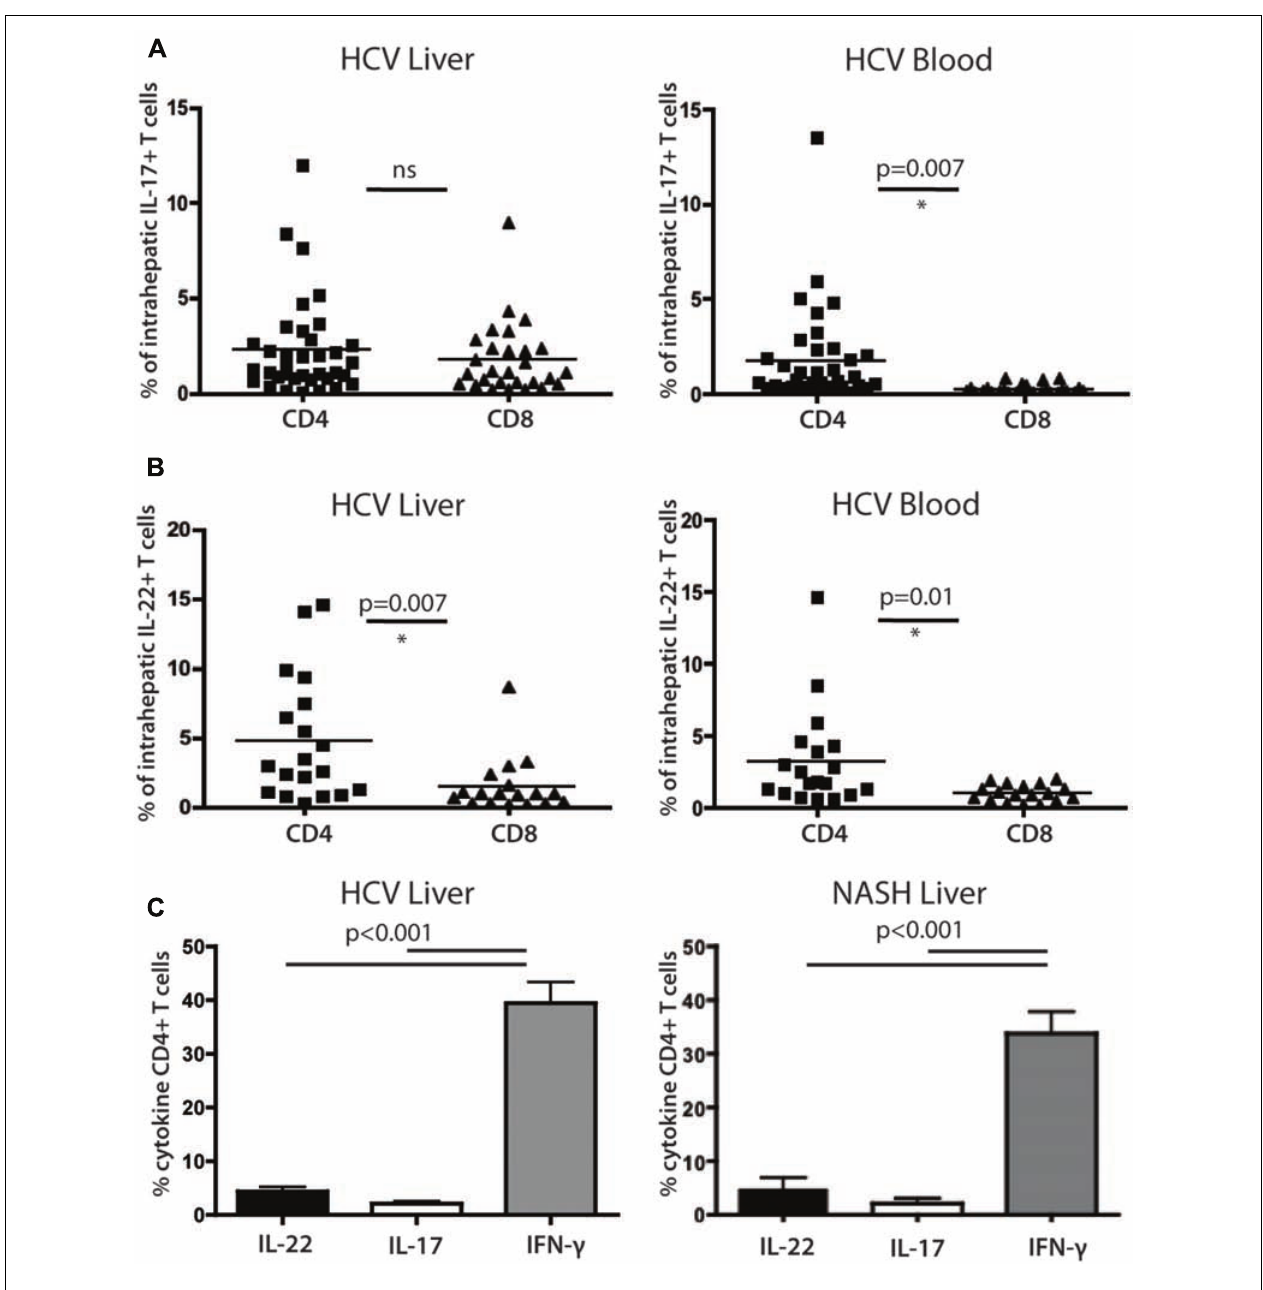
FIGURE 4 |Analysis of cytokine secreting cells in the liver of HCV + persons and controls. (A) Liver-derived and blood-derived CD4 + and CD8 + lymphocytes were analyzed for their cytokine secretion capacity as described in methods.The fractions of cells secreting IL-17A